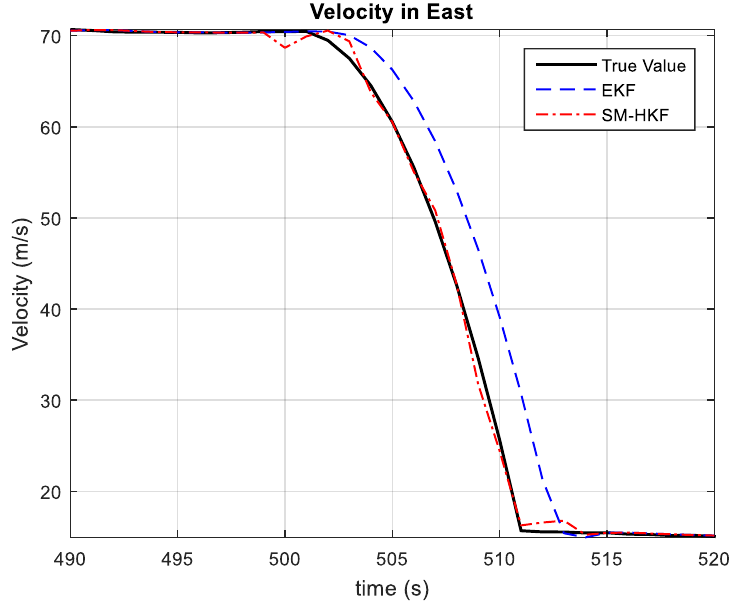
Sensors 2020 , 20 , 627 Figure 5. The velocities in East estimated by EKF and SM-HKF from 490 s to 520 s.